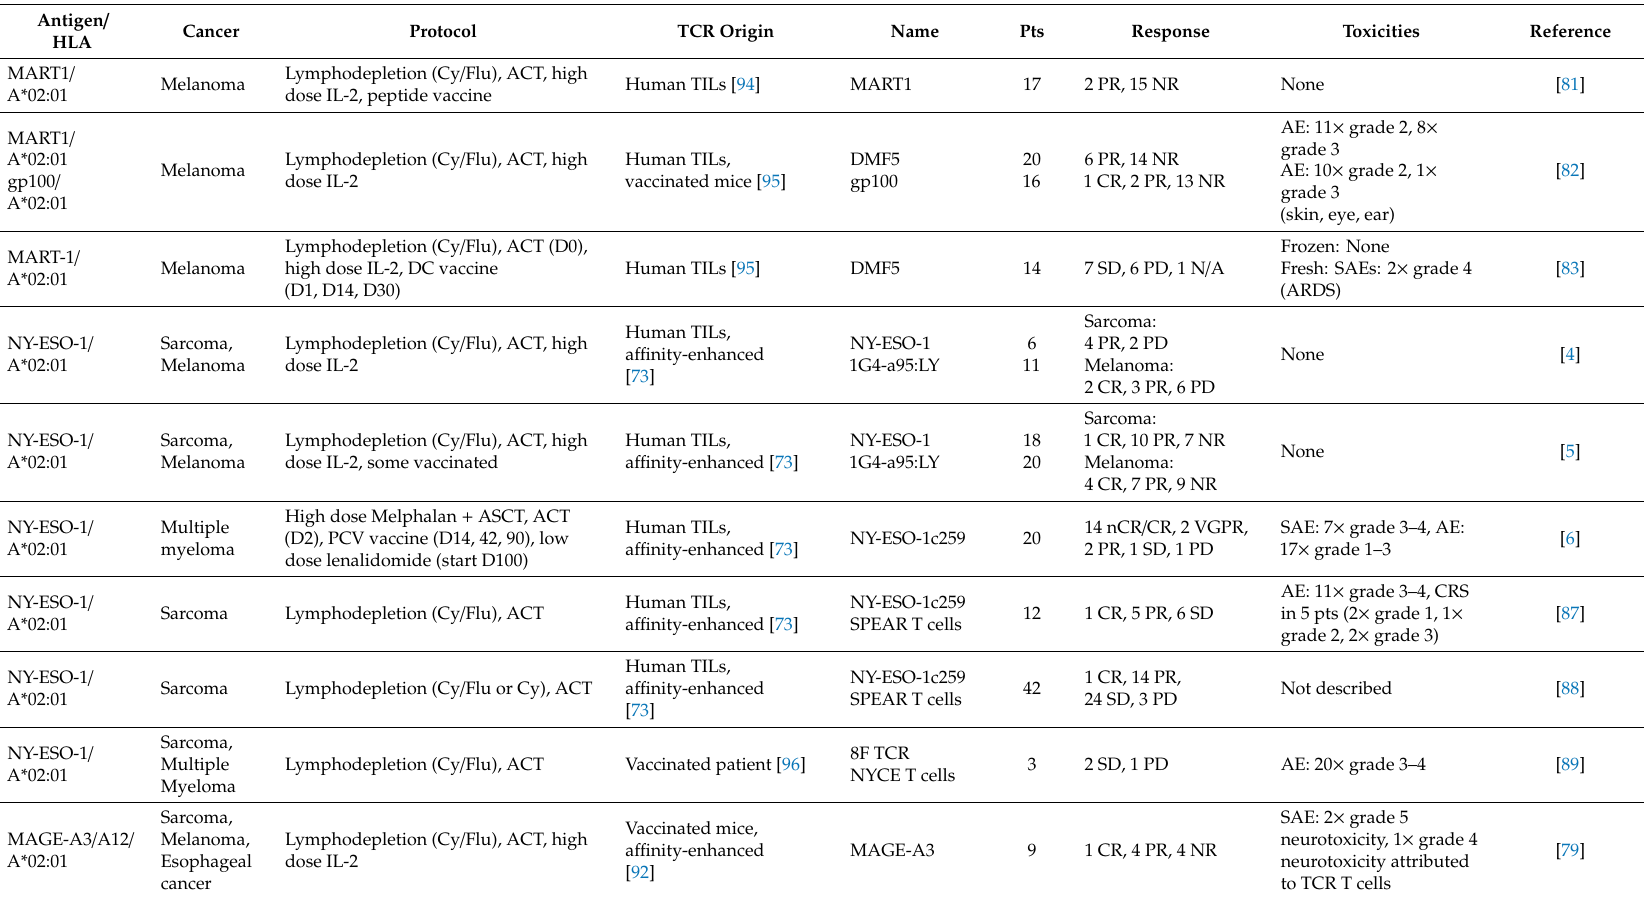
Table 1. Completed clinical trials with TCR transgenic